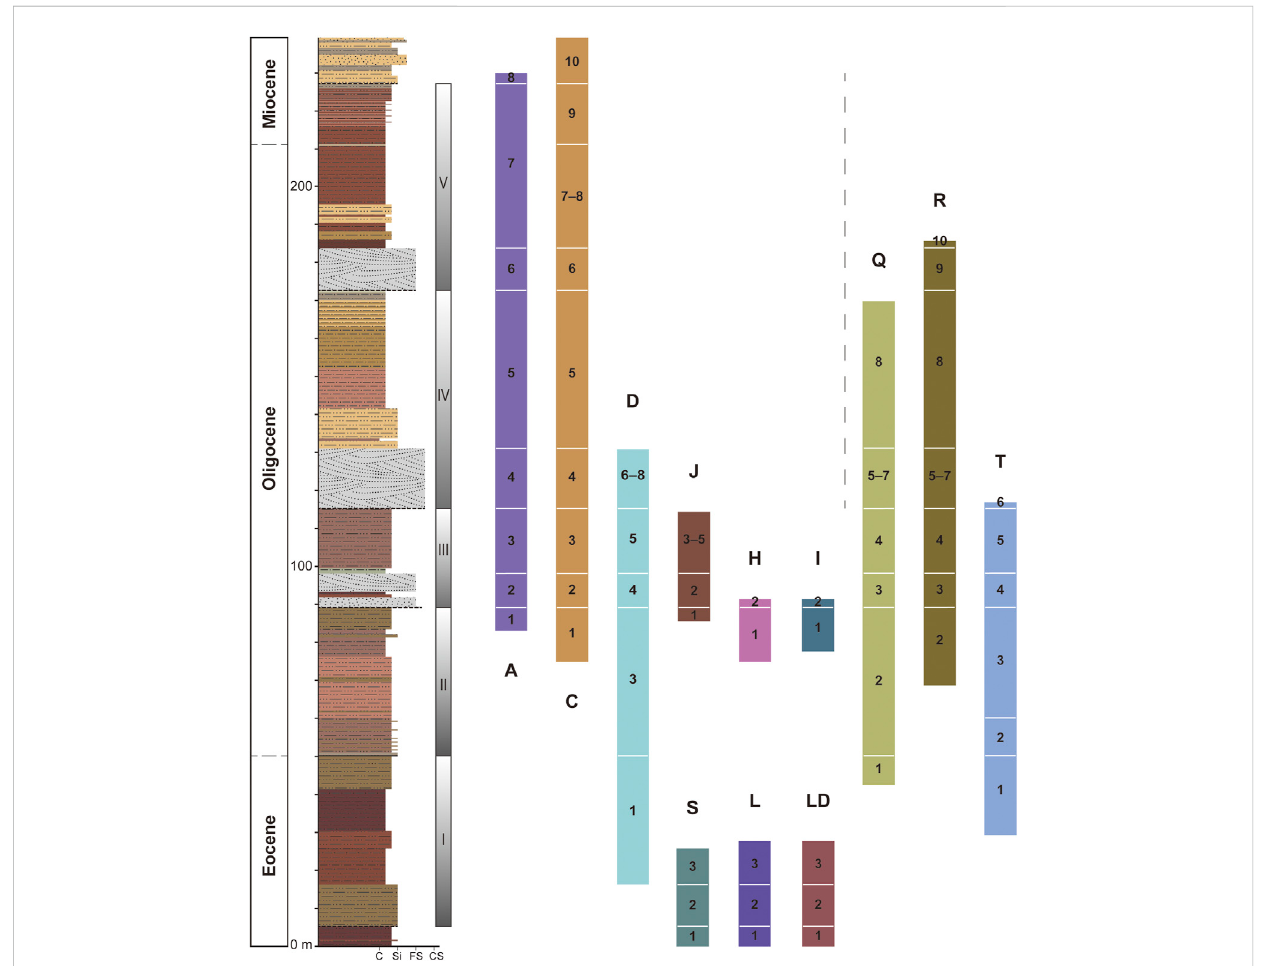
FIGURE 3 Composite stratigraphic pro fi le for Saint Jacques (left column) and lithostratigraphic correlation of the main fossiliferous blocks (colored bars). Thicknessesoflitho-unitsinindividualblocksarenottoscale.ColorschemeofblocksmatcheslegendinFigure1.Grain-sizescale:C=clay;Si=silt;FS= fi ne sand; CS = coarse